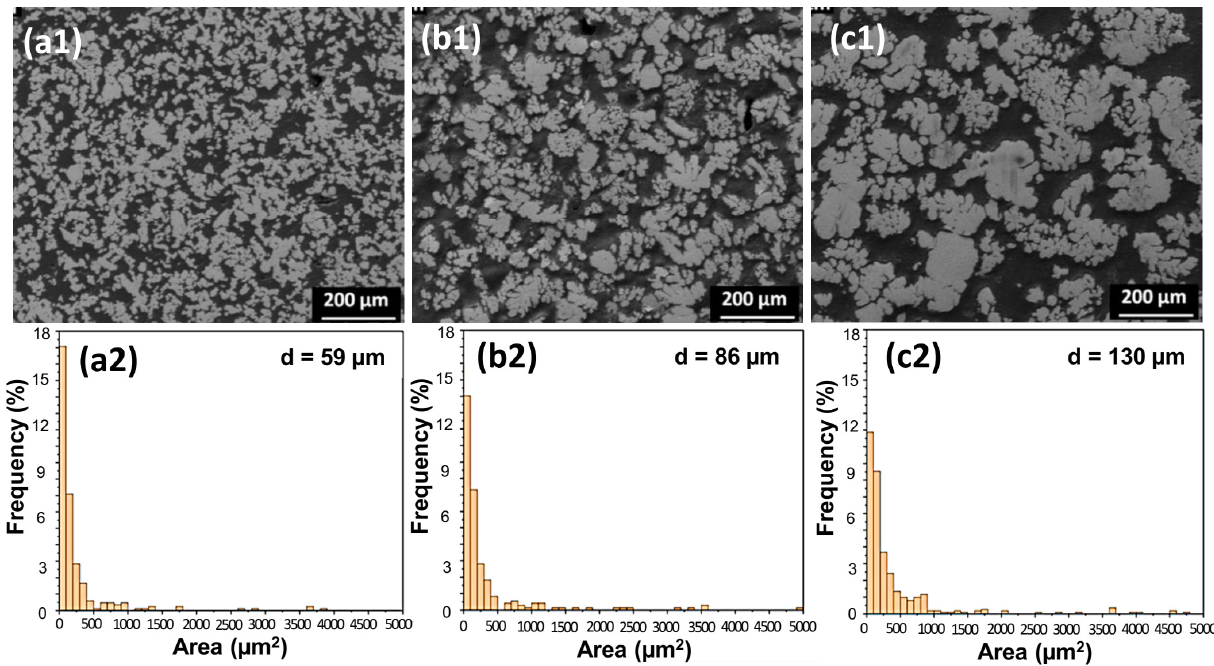
Figure 7. Cross-sectional SEM image and pore area distribution of the samples prepared by using different dendritic Cu powders after sintering ( a1 , a2 ) 59 μ m, ( b1 , b2 ) 86 μ m, and ( c1 , c2 ) 130 μ m.